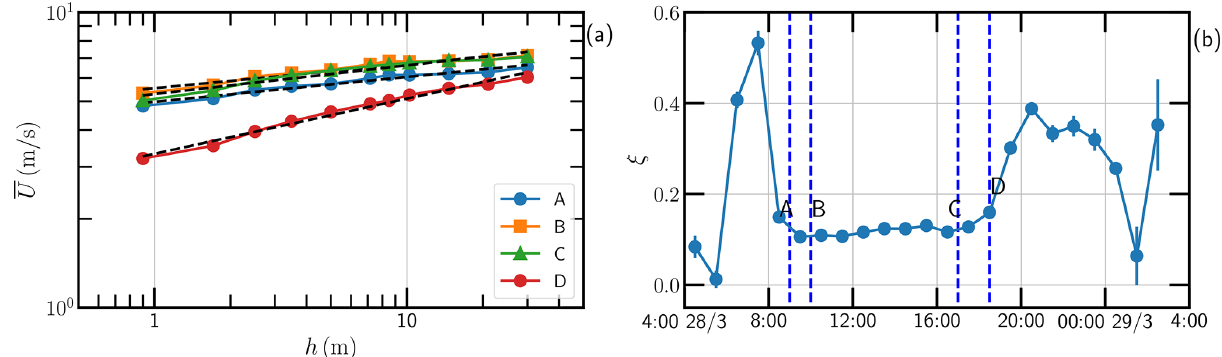
Figure 9. (a) Examination of the power-law relation, i.e., U ( h ) ∝ h ξ , at four typical periods from A to D. The dashed line is a power-law fitting for reference. (b) Temporal evolution of the power-law scaling exponent ξ